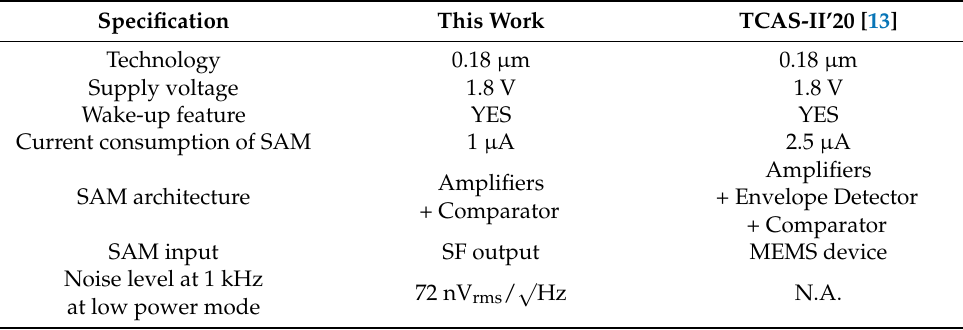
Table 1. Performance summary and comparison table with previous